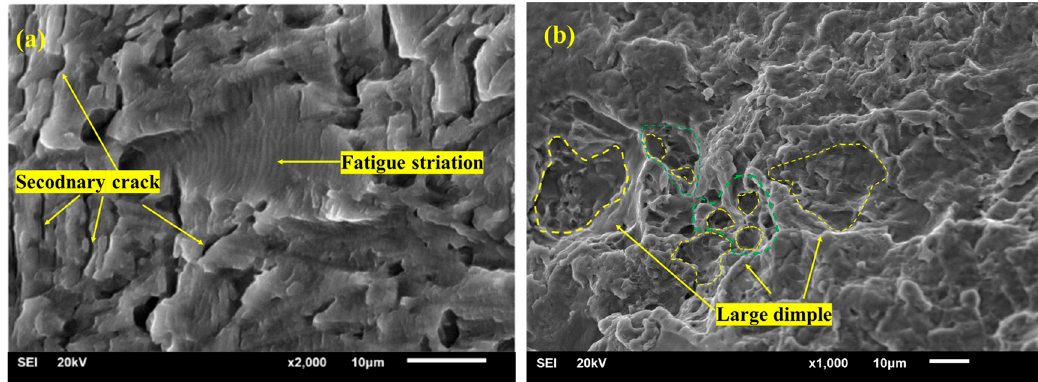
Figure 7. View of crack propagation region and final rupture region of Ti6Al4V specimen treated with LSP. ( a ) Crack propagation region; ( b ) Final rupture